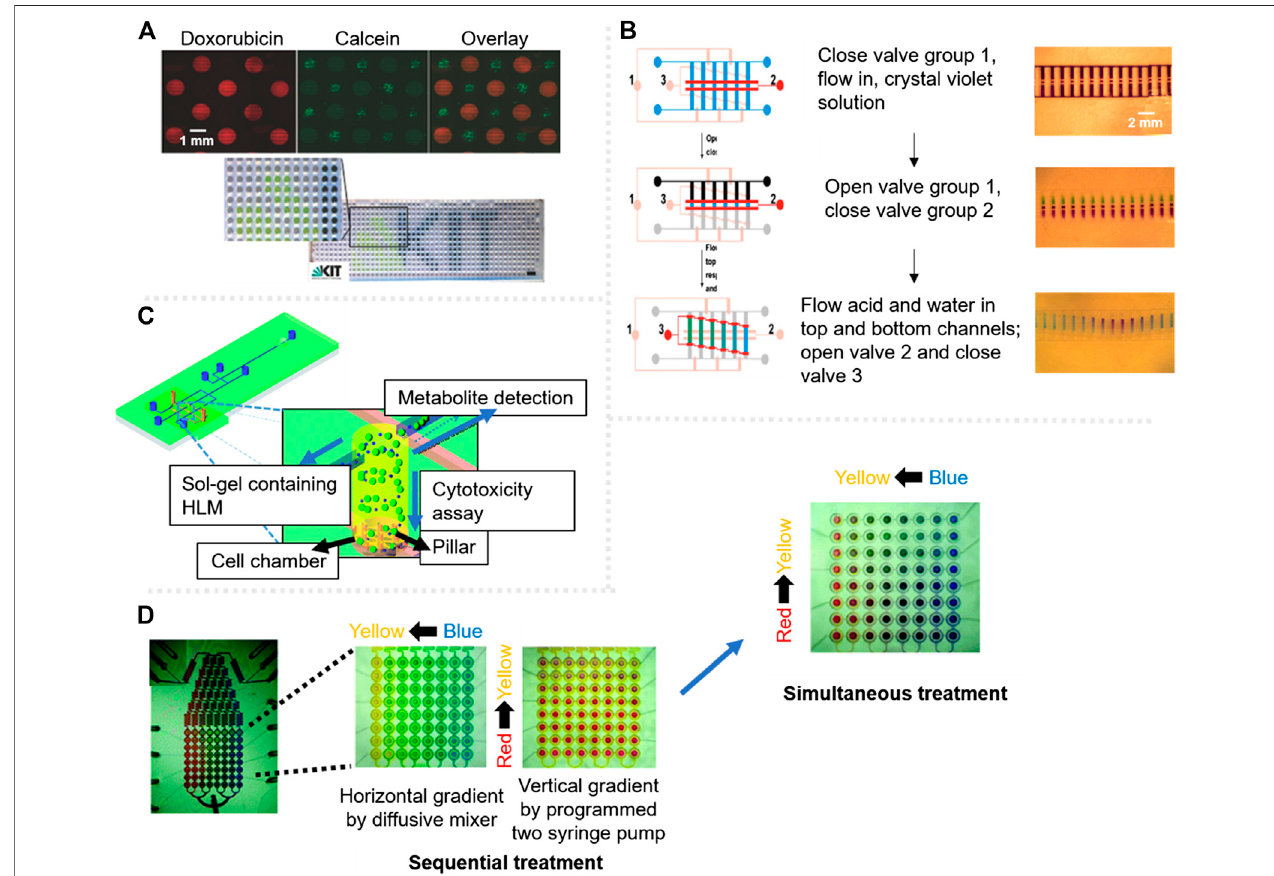
FIGURE 3 | Cytotoxicity assessment microsystems with fl uorescent label based detection. (A) Droplet based platform showing cells after 18 h in the presence of doxorubicindrug(red)andcalceinstainedcellsforviabilitytest (green);thescalebar inbottompictureis3 mm. Adaptedfrom(Popovaetal.,2015). (B) Schematicofthe stepwise gradient operation on chip, signalling valves with colors, red for the open ones and pink for the closed ones. The fl uidic channels are fabricated in a ladder shape, each colored channel represents a different solution. Adapted from (Dai et al., 2010). (C) Scheme of a three-layered microdevice for the simultaneous characterisation of drug metabolites and cytotoxicity assessment. Adapted from (Ma et al., 2009) with permission from The Royal Society of Chemistry. (D) Integrated micro fl uidic device for combinational cytotoxicity assessment by sequential treatment or simultaneous treatment. Adapted from (Kim et al., 2012) with permission from The Royal Society of